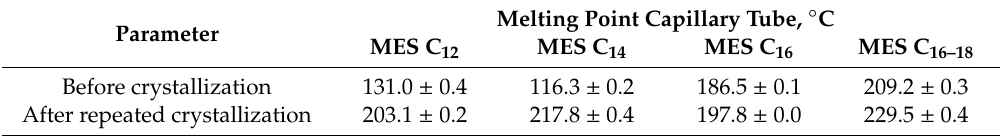
Table 6. Melting point of MES.